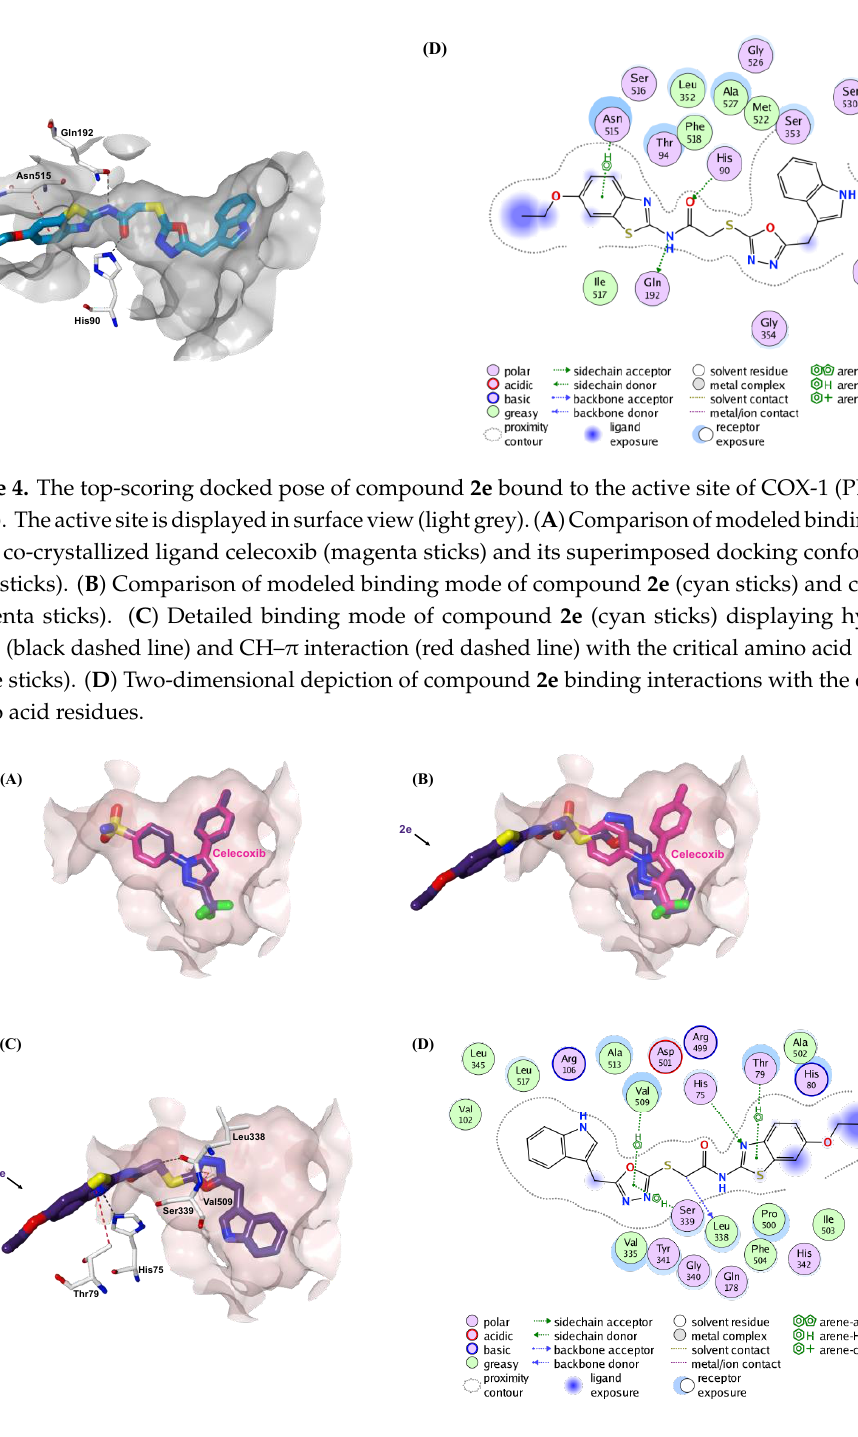
Figure 5. The top-scoring docked pose of compound 2e bound to the active site of COX-2 (PDB code 3LN1). The active site is displayed in the surface view (light pink). ( A ) Comparison of modeled binding mode of the co-crystallized ligand celecoxib (magenta sticks) and its superimposed docking conformation (violet sticks). ( B ) Comparison of modeled binding mode of compound 2e (violet sticks) and celecoxib (magenta sticks). ( C ) Detailed binding mode of compound 2e (violet sticks) displaying hydrogen bonds (black dashed line) and CH– π interaction (red dashed line) with the critical amino acid residues (white sticks). ( D ) Two-dimensional depiction of compound 2e binding interactions with the essential amino acid